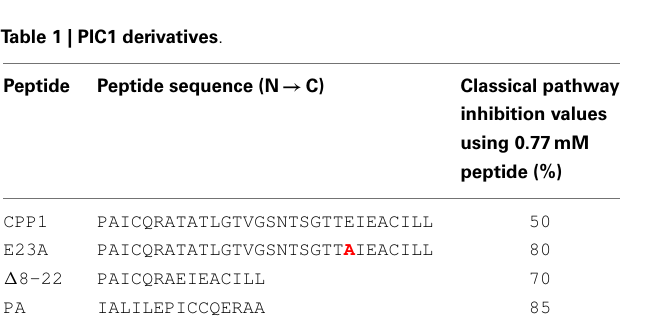
Table 1 | PIC1 derivatives .